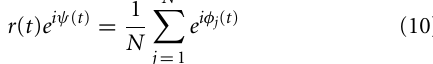
of T = 10 5 .Thespinsformamoreorlessrandompatternacrossthelattice. (B) The Ising lattice near critical temperature, T = 2 . 3. The lattice contains clusters of spins that are both small and large. Note that these are snapshots and that the spin structure of the model is best appreciated when evolving across